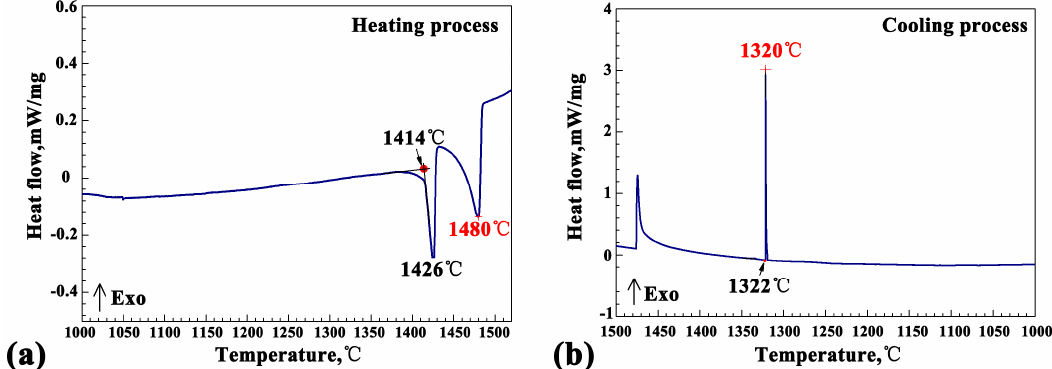
Figure 3. Differential scanning calorimeter (DSC) curve of H13 in this study ( a ) Heating process and ( b ) cooling process, respectively.